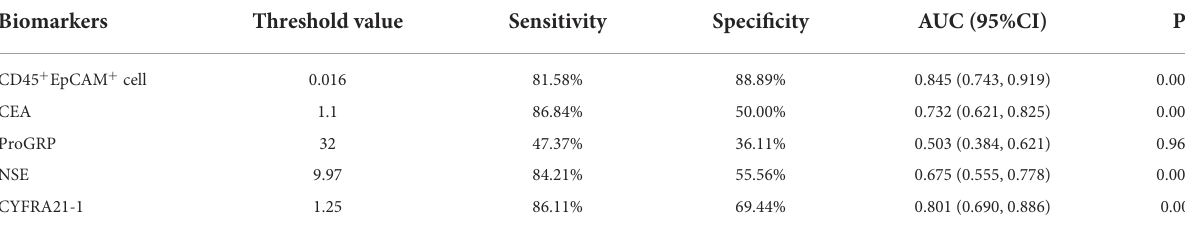
TABLE 4 Statistical analysis of ROC/AUC for serum biomarkers’ level and CD45 + EpCAM + cell ratio in PBMCs of healthy volunteers and lung cancer patients.